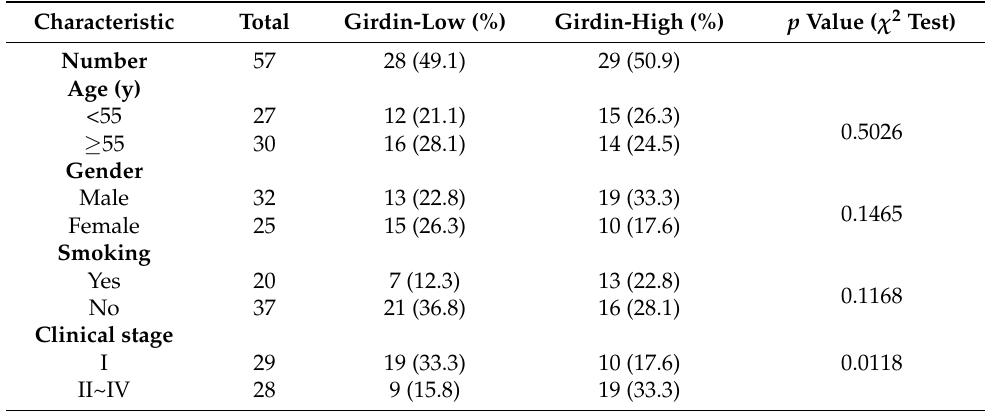
Table 5. Clinicopathological characteristics of LUAD